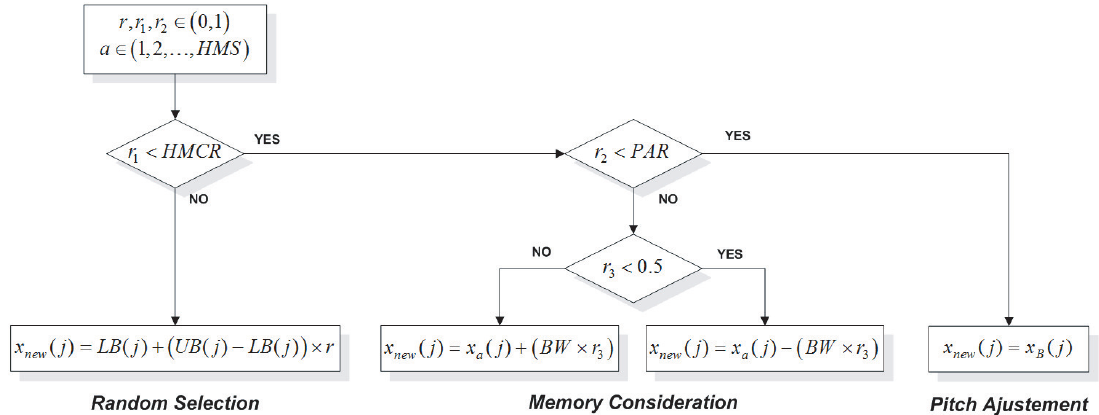
Figure 10. Improvisation process in Self-adaptive Global-best Harmony Search (SGHS) algorithm.